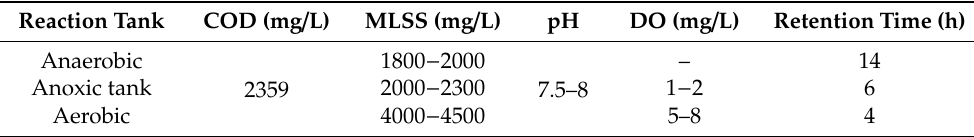
Table 1. Initial operating parameters of A2O-MBBR system.